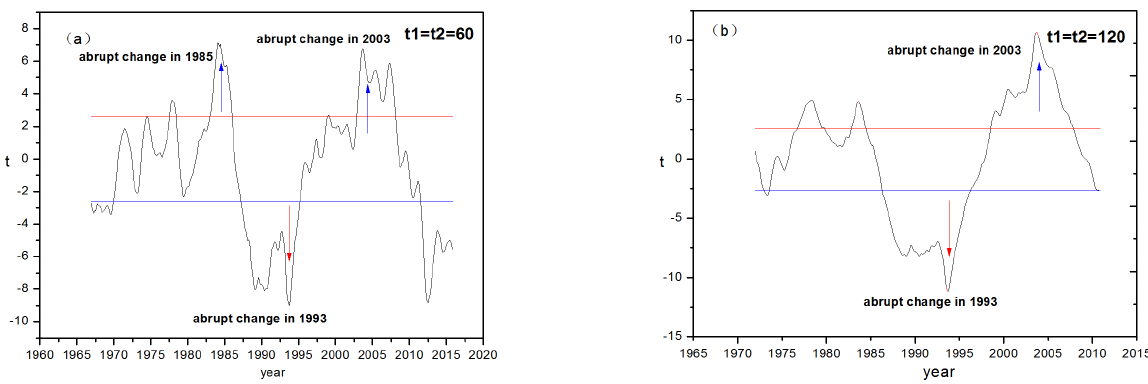
Figure 3. Detection of the abrupt change in the SPI sequence over the Dongting Lake basin based on the moving t -test (MTT) method with the size of the sliding window being. ( a ) 5 years (60 months) and ( b ) 10 years (120 months), respec- tively.